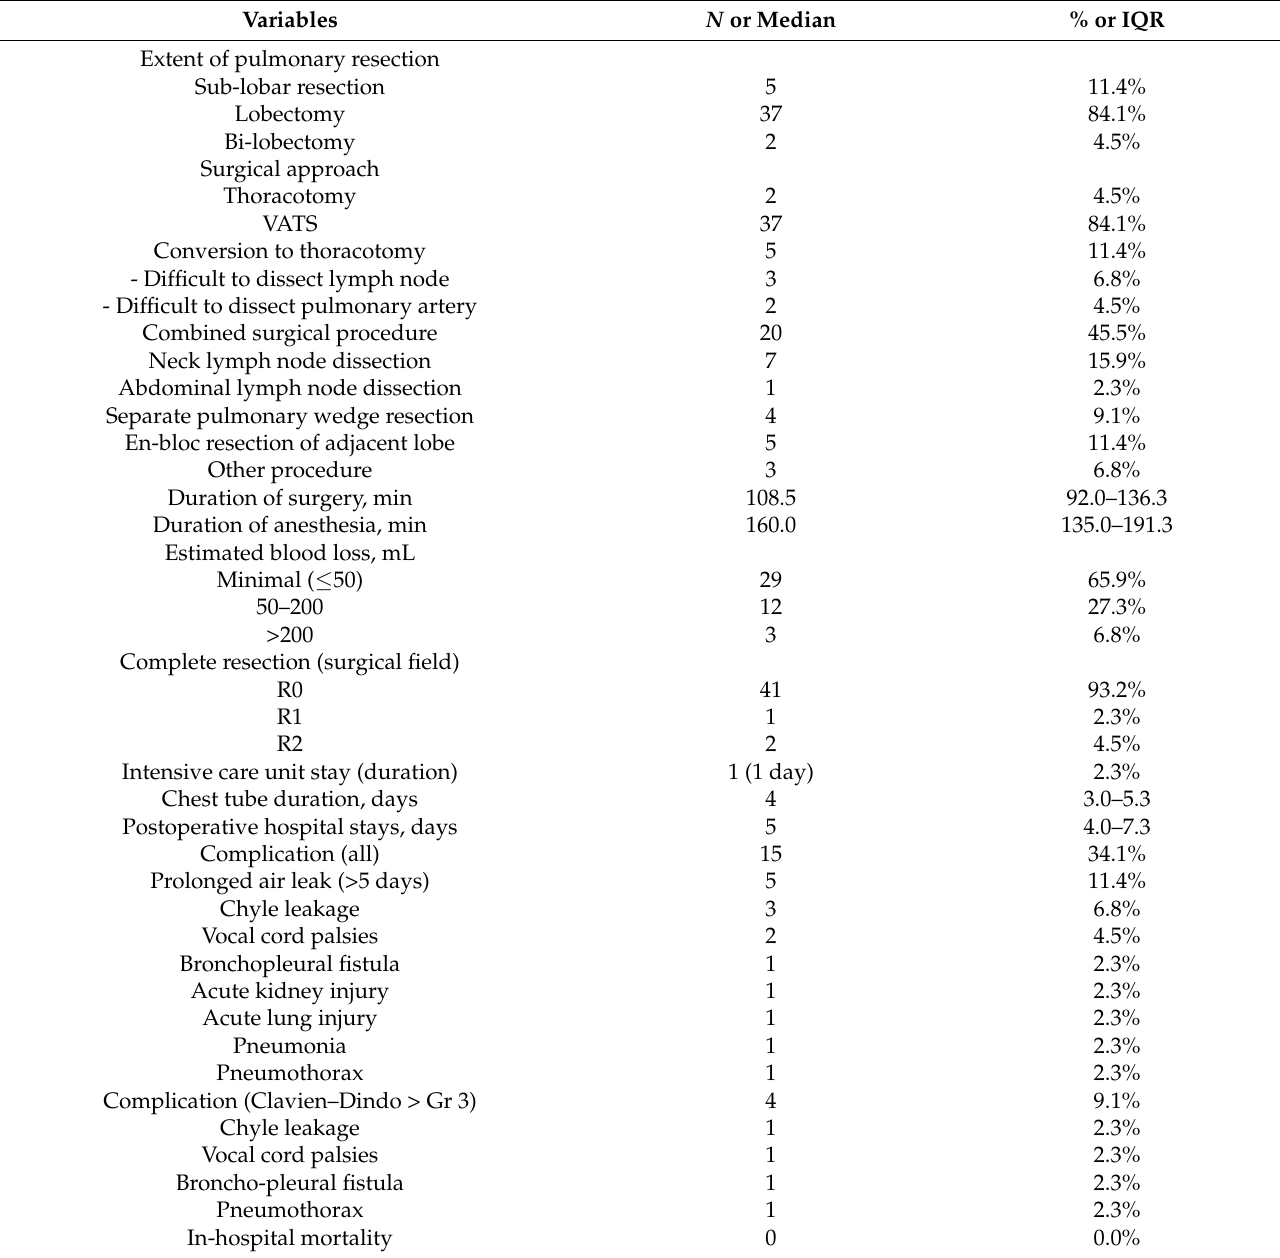
Table 3. Operative